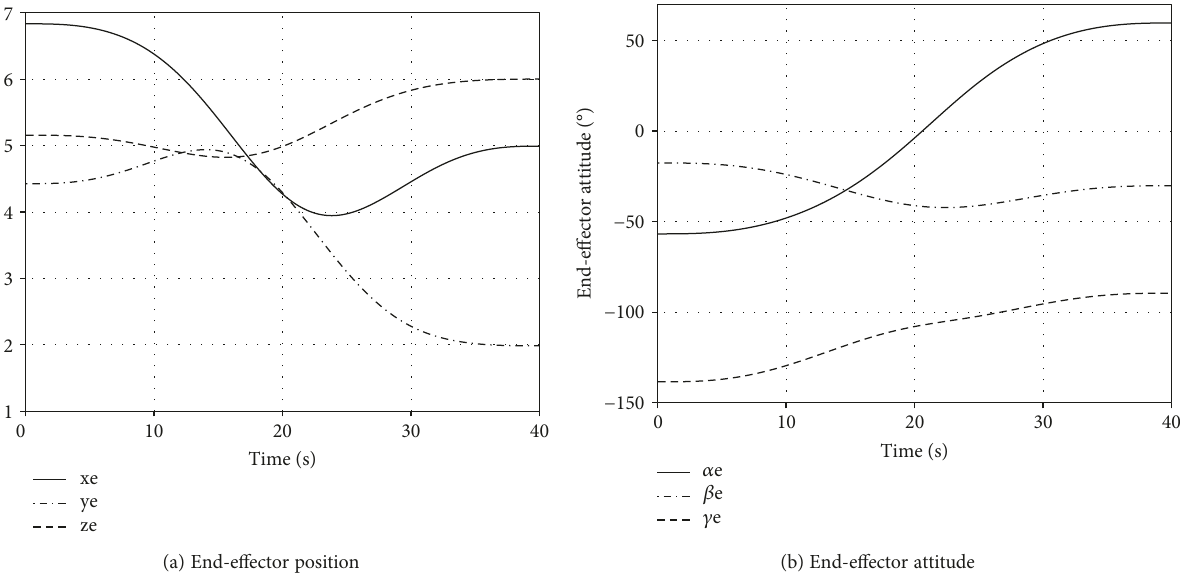
T with execution of the trajectory tracking task. Ψ T e , e